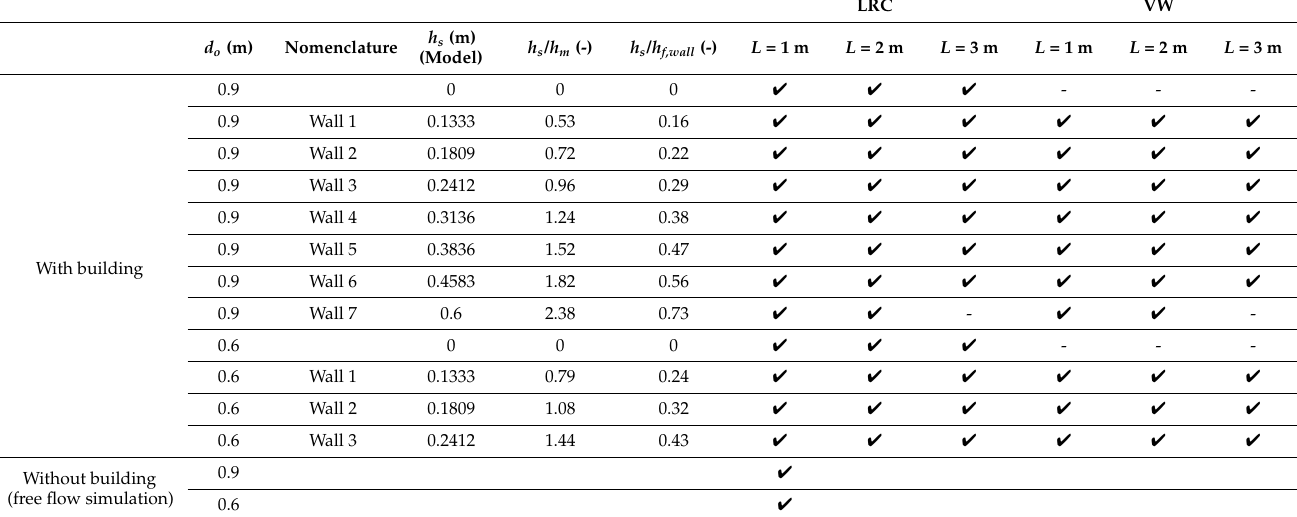
Table 1. Simulation